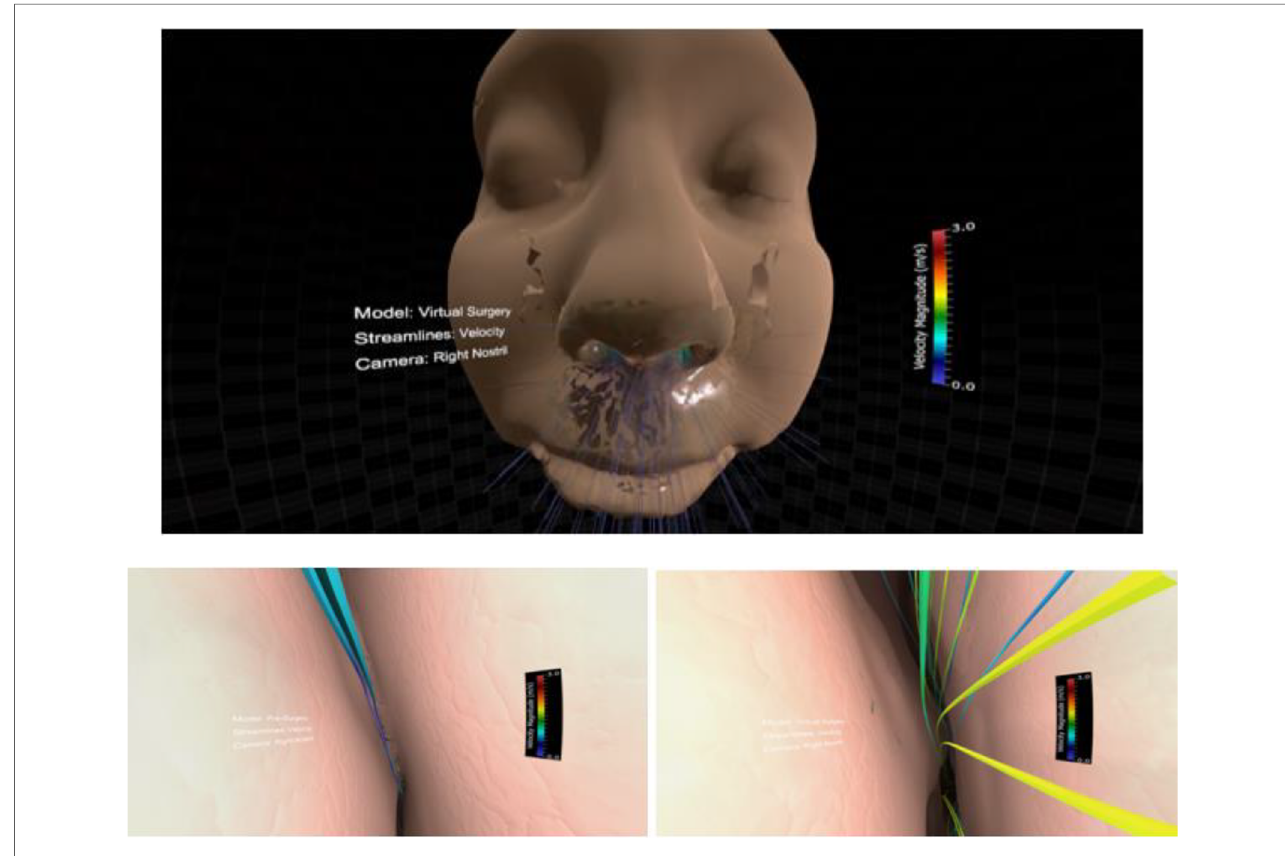
FIGURE 7 Screenshots from immersive viewing of nasal airway data with application to virtual treatment planning using the Oculus Rift. Initial view of the scene using a representative geometry (top) along with views of velocity streamlines from inside the right nasal cavity pre-surgery (lower left) and post-surgery (lower right). Note the increase in velocity post-surgery following removal of the obstructed region resulting in increased regional fl